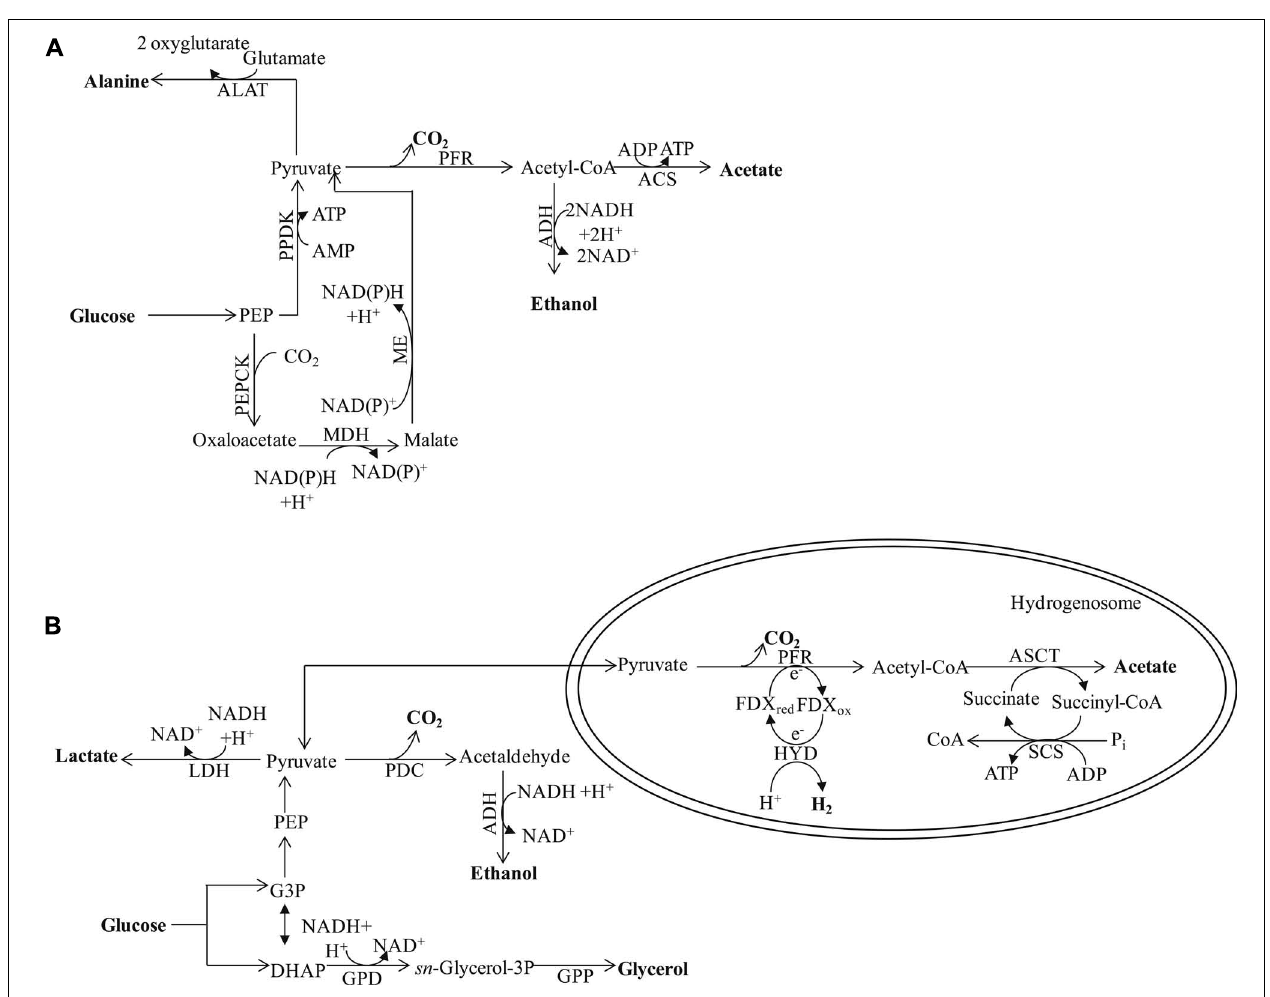
Trichomonas vaginalis . Hydrogenosomal pyruvate breakdown involves PFR and functional [FeFe]-hydrogenase (HYD) in Trichomonas . Additional major end products of cytosolic fermentation in Tvaginalis vaginalis include alanine, lactate, ethanol, and glycerol.The protein designations in this figure are: ALAT for alanine aminotransferase and PPDK for pyruvate:orthophosphate dikinase. See Figures 1–3 for the other protein